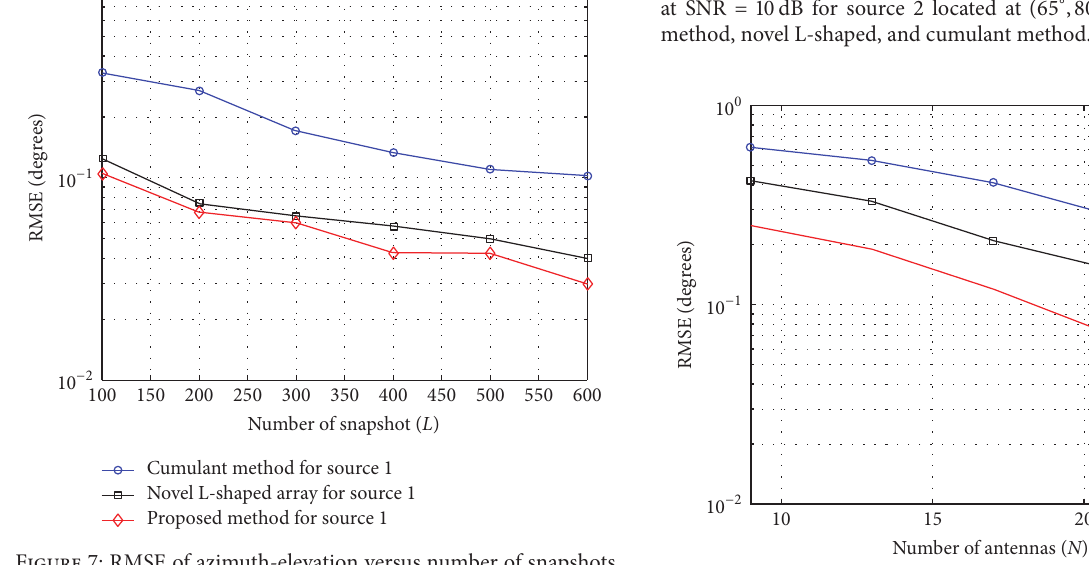
Figure 7: RMSE of azimuth-elevation versus number of snapshots at SNR = 10dB for source 1 located at (45 ∘ ,50 ∘ ) using proposed method, novel L-shaped, and cumulant method.